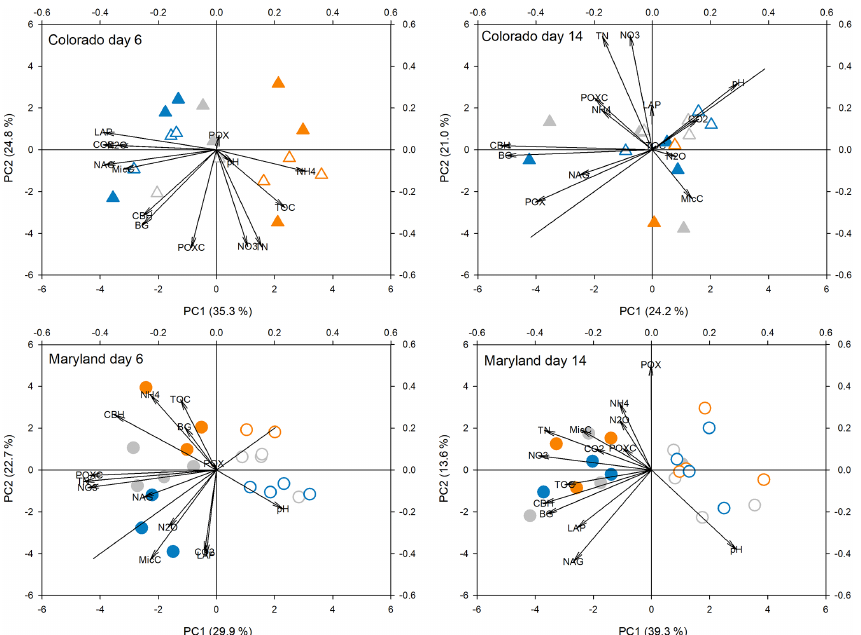
Figure 4. Principal components analysis of all response parameters at first peak stress (day 6) and following the first stress (day 14) in soils from Colorado and Maryland. Blue symbols are the flooding treatment and orange symbols are the drought treatment. Gray symbols are the control. Open symbols represent simple and filled symbols represent complex rotations. Significant differences between treatments along the axes are shown in Table 2. Included parameters are pH, extractable organic carbon (EOC), total extractable nitrogen (TEN), microbial biomass carbon (MBC), NH 4 , NO 3 , activities of β -glucosidase (BG), cellobiohydrolase (CBH), N-acetyl-glucosaminidase (NAG), leucine-amino- peptidase (LAP), phenoloxidase (POX) and peroxidase (PEX), respiration (CO 2 ), N 2 O production (N 2 O), and permanganate oxidizable carbon (POXC). Table 2. Results from analysis of variance of treatments on axis from PCAs as seen in Figs. 4 and 5. Bold values represent significant differences between treatments (drought, flooding, and control). PC1 PC2 Treatment Rotation Interaction Treatment Rotation